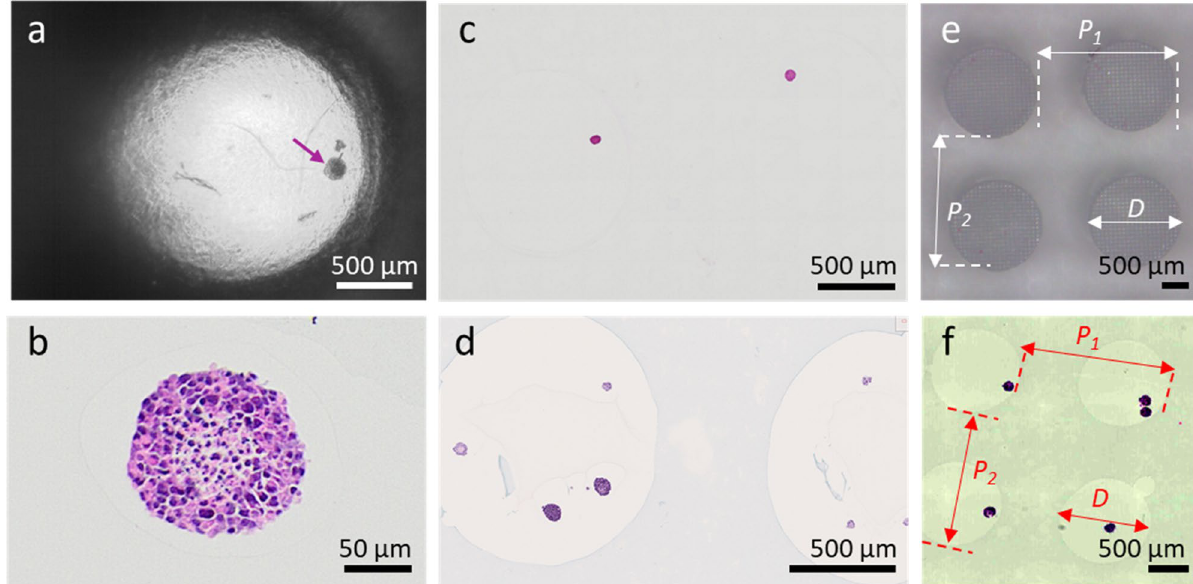
Figure 5. Images of HepG2 micro-tissues in a HistoBrick undergoing different processing steps. ( a ) A HepG2 micro-tissue (pointed by the arrow) after being embedded in the HistoBrick and topped with HistoGel. Note no air bubbles are trapped inside the micro-well, ( b ) H&E staining of a section of a single micro-tissue, ( c ) Microscopy image of a slice without dye. The well contours are difficult to determine. ( d ) Microscopy image of a slice using a blue coloured stain. Note the well contours are clearly visible. ( e ) Measuring the diameter and pitch of the wells in the HistoBrick before paraffin embedding, ( f ) Measuring the diameter and pitch of the wells in the HistoBrick after sectioning. The parameter D is the diameter whereas P 1 and P 2 are used to compare the pitch on the two axes of the micro-well